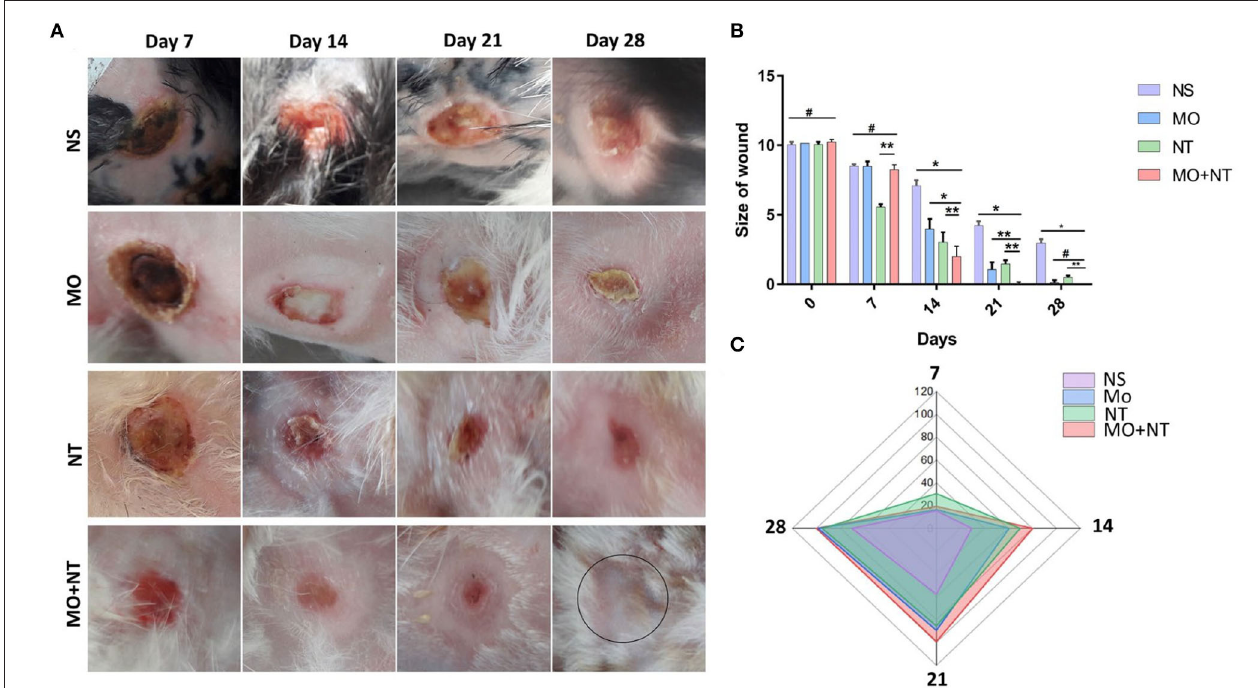
FIGURE 3 | (A) Digital photographs of wounds taken on different days (7, 14, 21, and 28). NS, normal saline; NS, normal saline; MO, Manuka honey ointment; NT, Nitrofurazone ointment; MO + NT, Manuka honey + Nitrofurazone. (B) Size of wounds, (C) contraction rate percentage (*p < 0.05, **p < 0.01, # p >